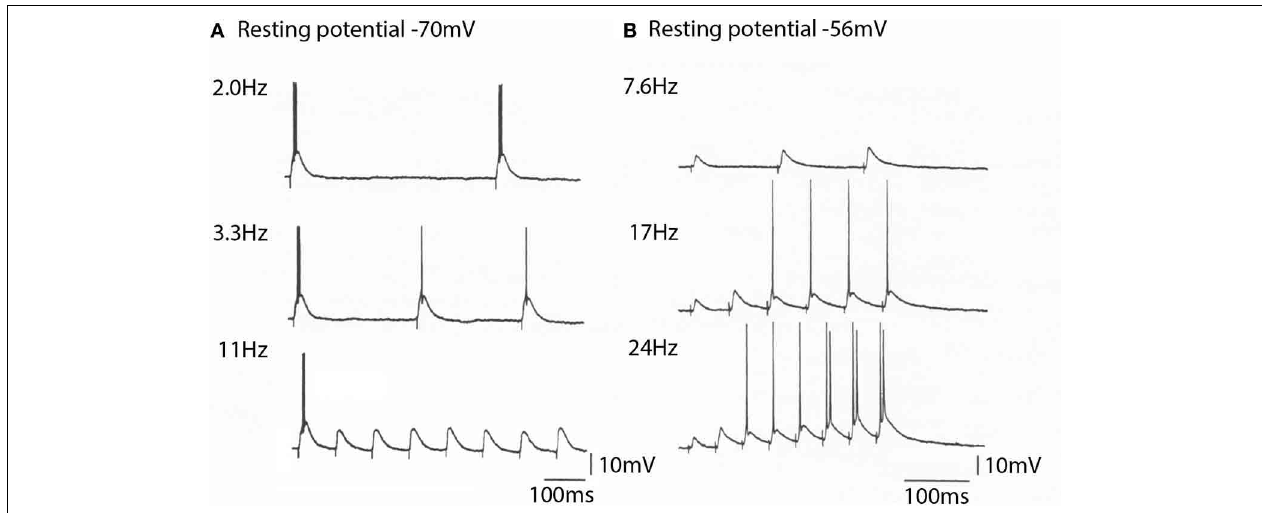
FIGURE 10 | The spike generation properties and EPSP amplitude generated by a thalamic neurons to cortico-thalamic volleys is membrane potential depend. (A) At − 70mV the thalamic cell generated spikes at frequencies bellow 10Hz. Note that the EPSPs generated are all of the same